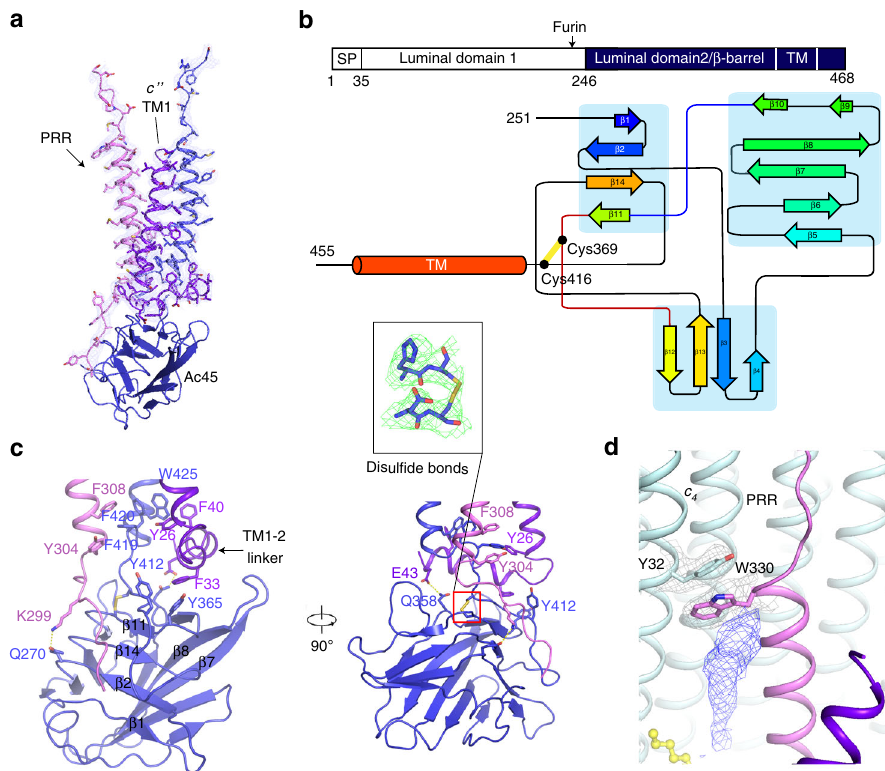
Fig. 4 Structure of the core of Vo domain. a The core of c-ring. Cryo-EM map of TMs of PRR, Ac45, and c ” in state 1 is shown at the 5 σ level. b The topology diagram of Ac45. The schematic diagram of full-length Ac45 is shown on the top. c The interaction details of luminal peptide of PRR with Ac45 and TM1-2 linker of c ” . The individual β -strand of Ac45 is labeled. The cryo-EM map of the disul fi de bonds is shown at the 5 σ level. d The interaction details of unknown lipid-mediated PRR and c 4 interaction. Cryo-EM maps are shown at the 5 σ